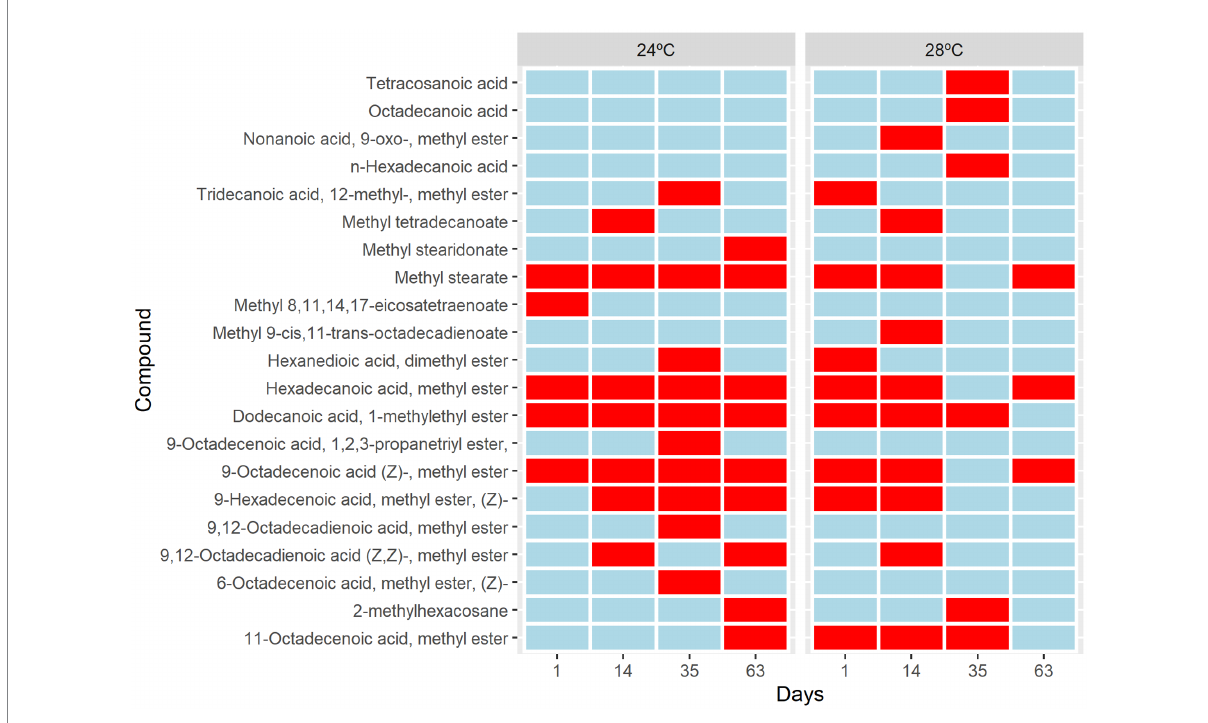
FIGURE 4 Metabolic changes in Cladocopium cultured at 24 ° C and 28 ° C. Heat map analysis showing the intensity of fatty acids composition in Cladocopium during 1, 14, 35, and 63 days. The Colour bar indicates levels of metabolite, the red colour indicates upregulation, and the blue colour indicates